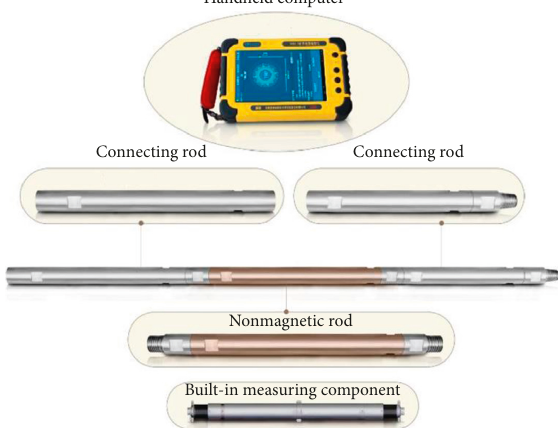
Figure 3: Layout of the VMWD